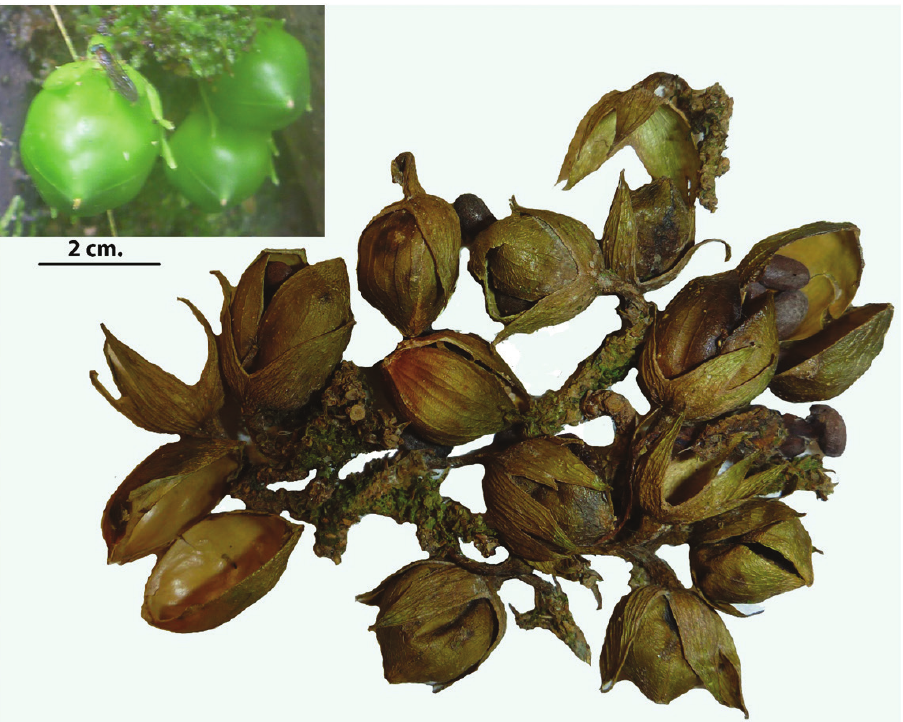
Figure 3. Fruits of Brunfelsia cabiesesiana . Below, dried, dehiscent capsules with seeds. Above left, developing fruits.